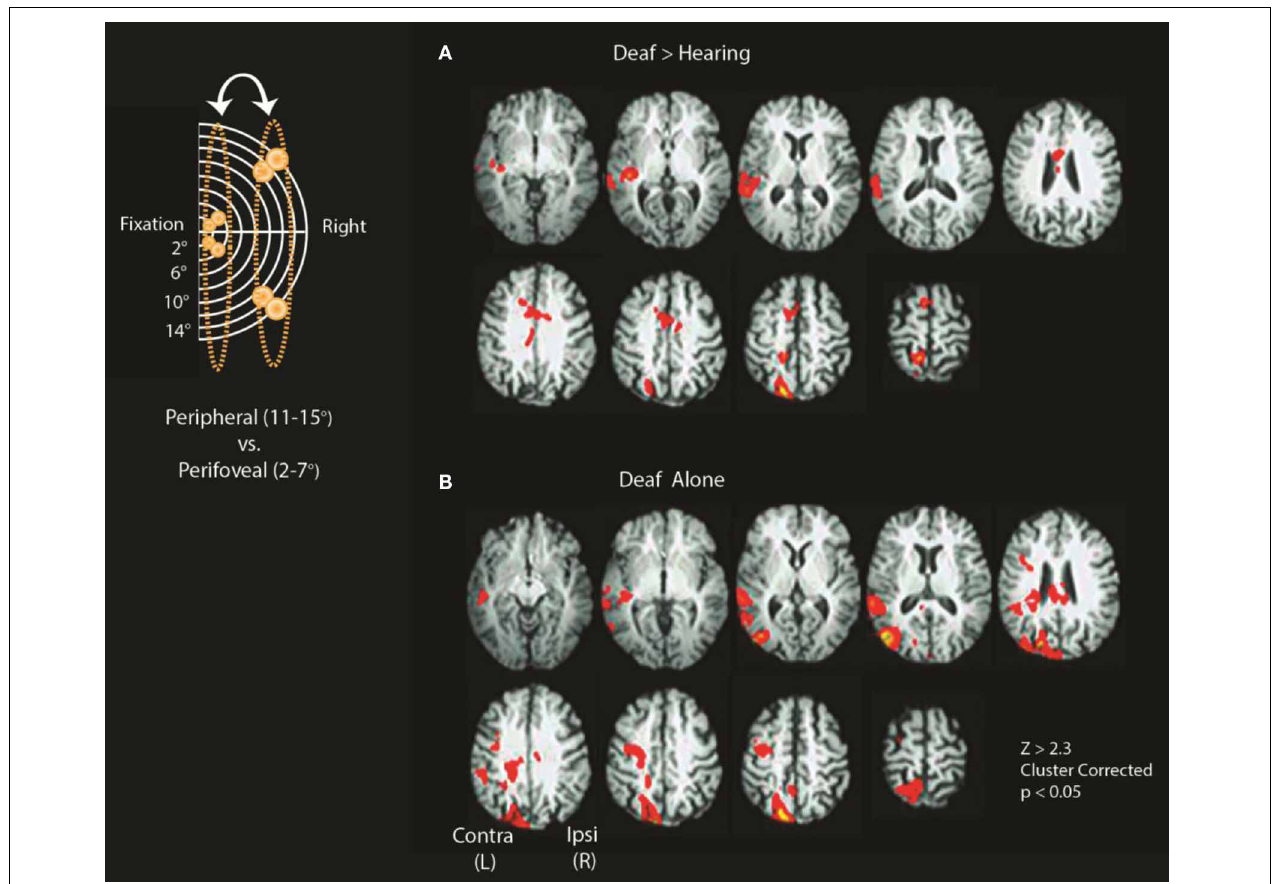
FIGURE 3 | Differences between deaf and hearing for peripheral vs. perifoveal stimulation. Inset shows a schematic location of stimuli included in the contrasts(11–15 ◦ vs.2–7 ◦ ). (A) Deaf > Hearingand (B) Deafalone.See Tables 1 , 2